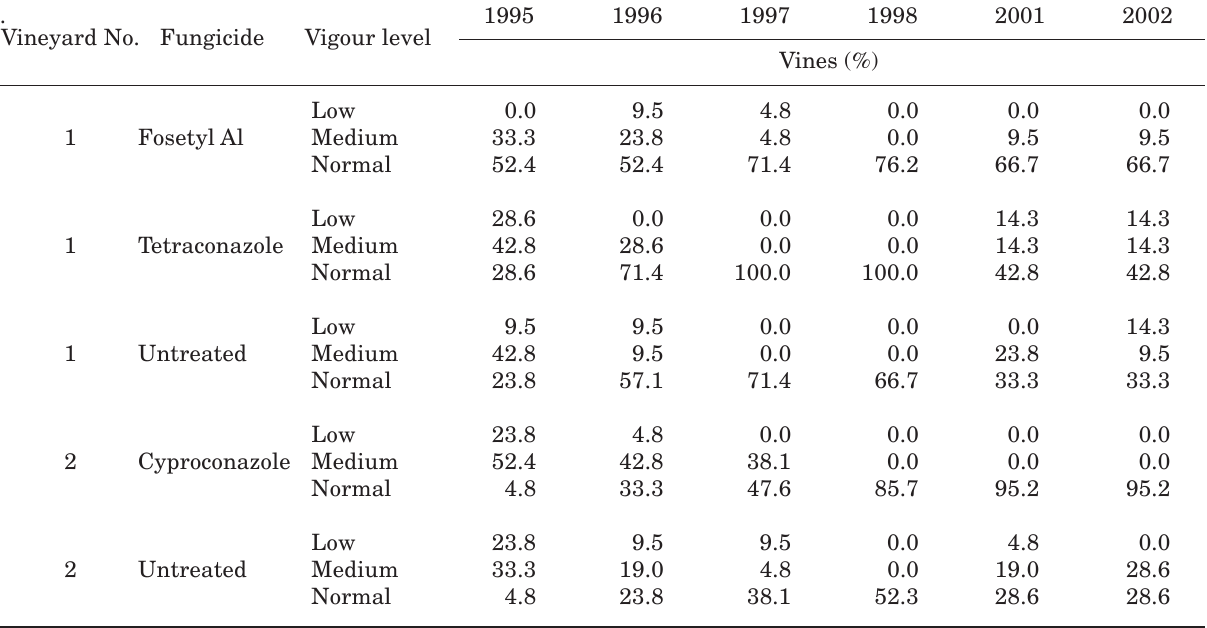
Table 3. Trunk injection: vigour of trunk-renewed vines during and after trunk injection of fungicide, grouped by vine vigour